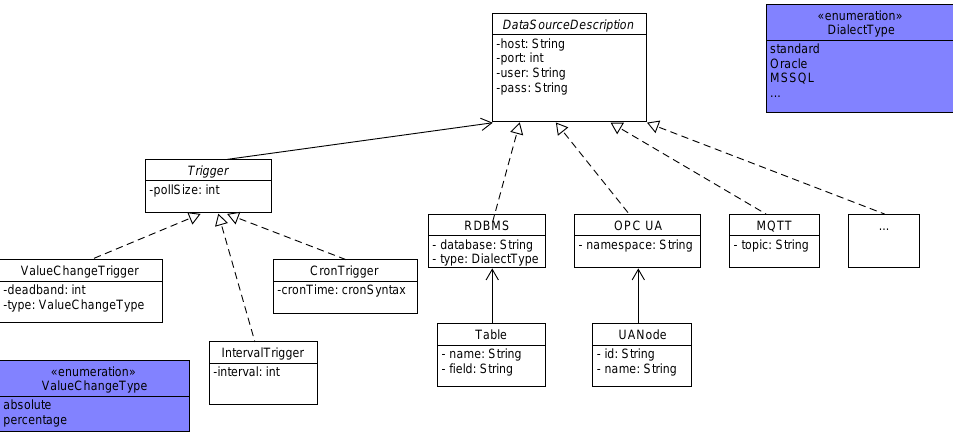
Figure 4. Diagram of the building blocks for the modular agent configuration describing a data